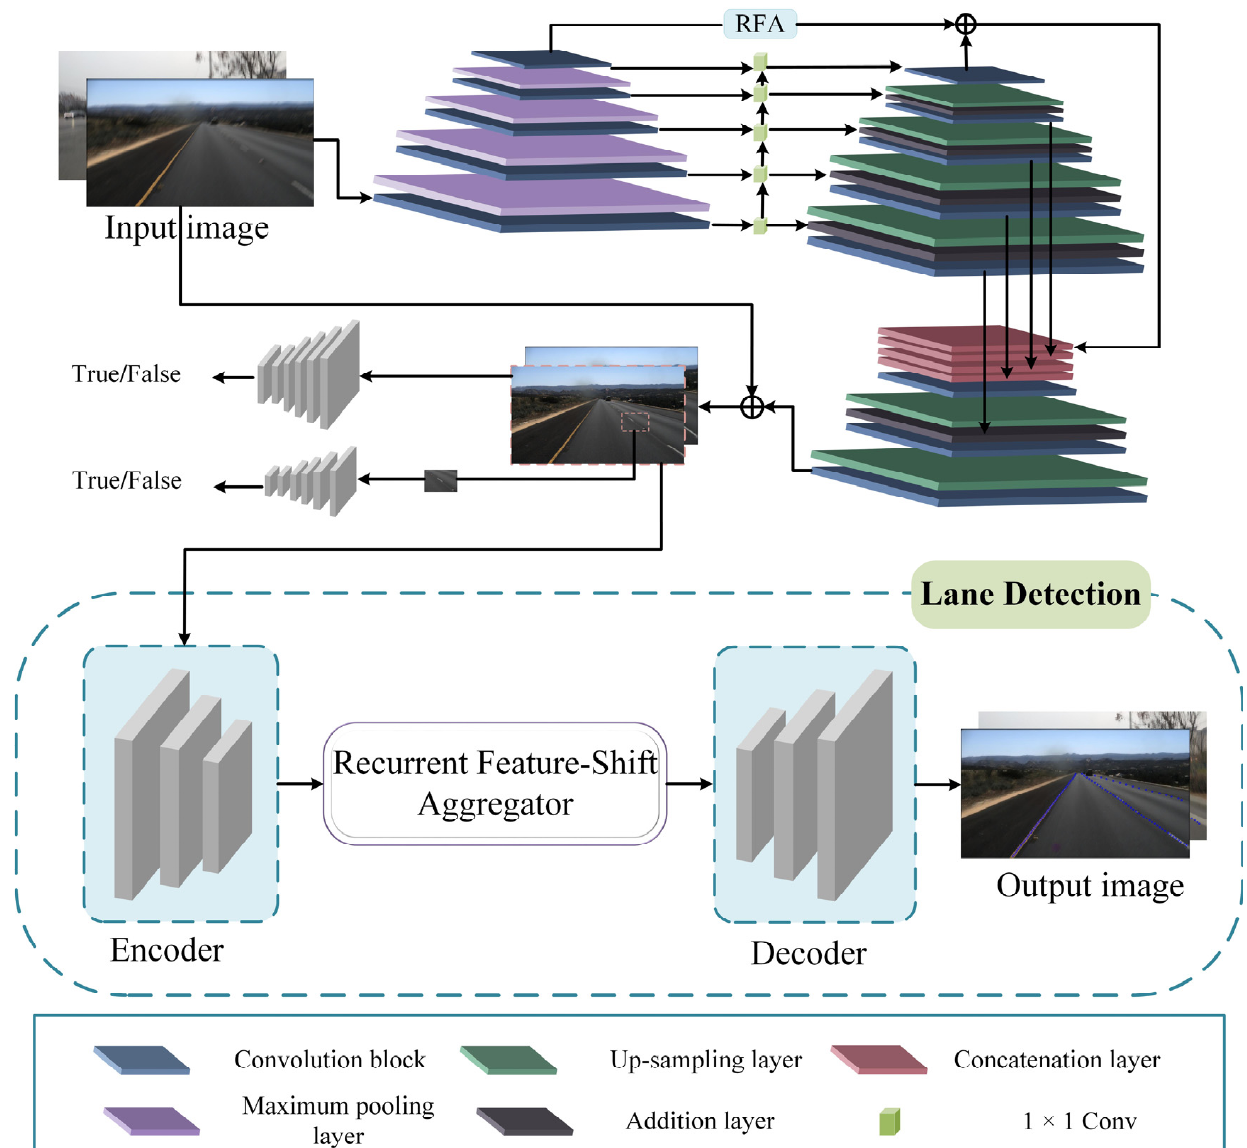
Figure 1. The architecture of proposed Lane-GAN.